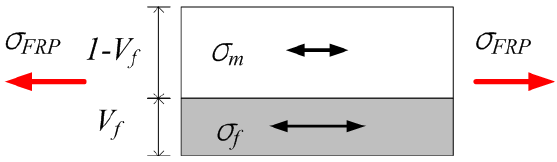
Figure 1. Schematic illustration of deformation of FRP under stress [9].